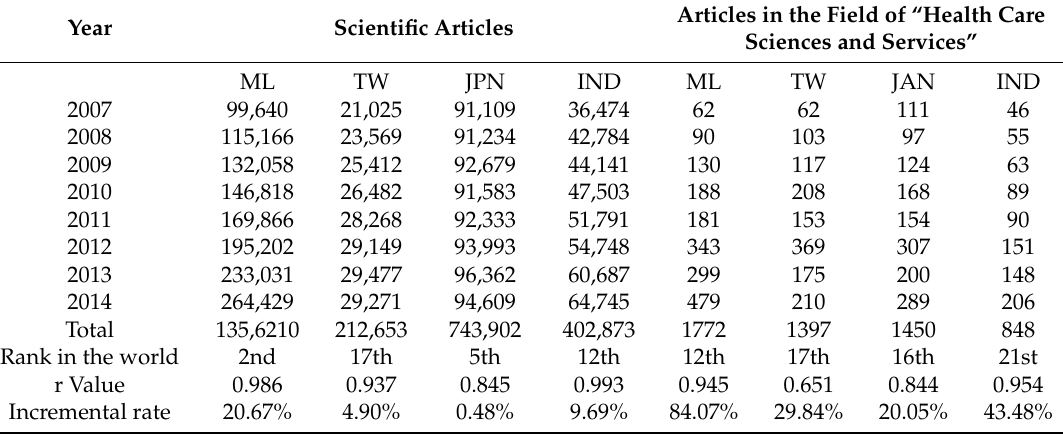
Table 1. Annual numbers of scientific articles and articles in the field of “health care sciences and services” published by researchers from Mainland China (ML), Japan (JPN), Taiwan (TW), and India (IND)